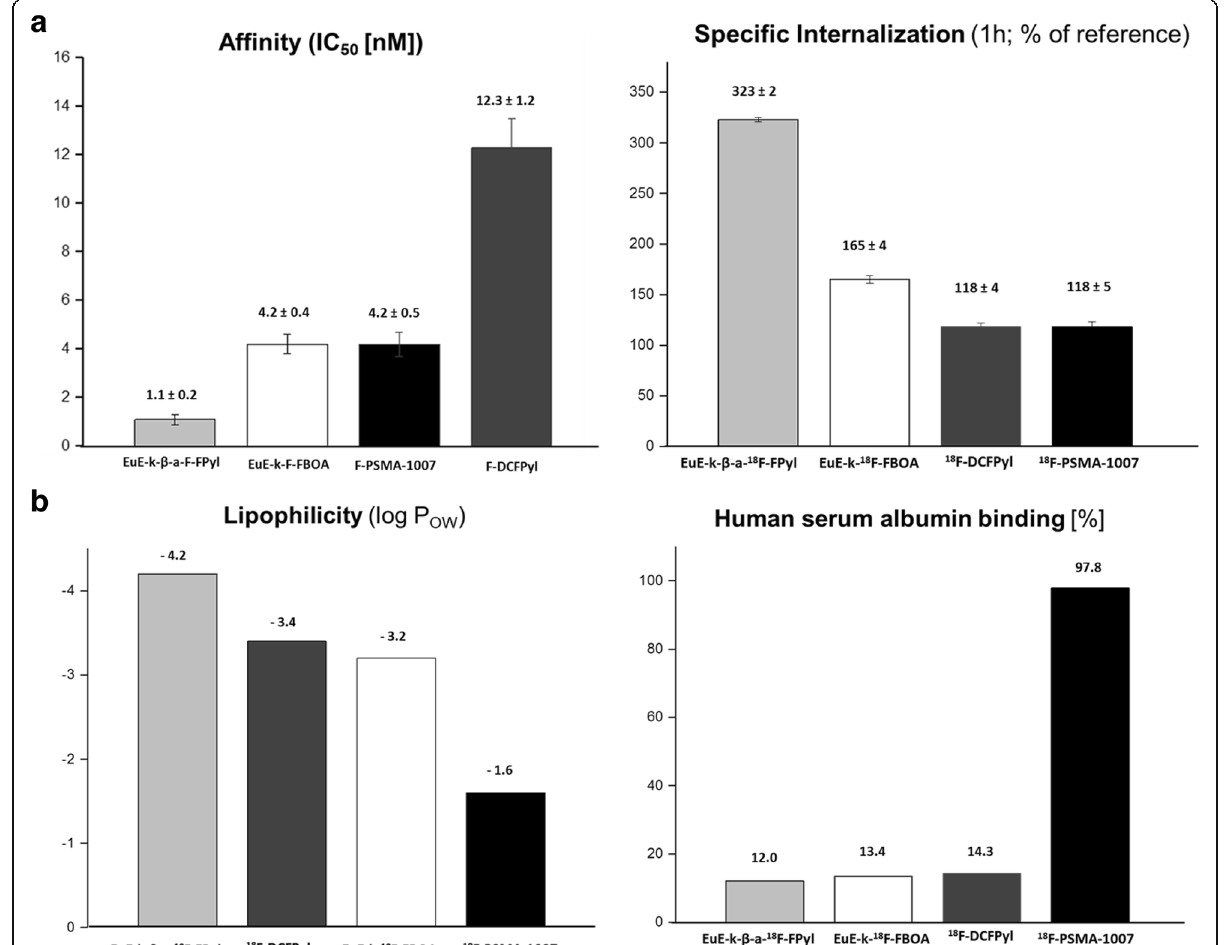
Fig. 2 a PSMA affinities of the cold EuE-based inhibitors, F-DCFPyl and F-PSMA-1007. Internalization of the 18 F-labeled EuE-based PSMA inhibitors, EuE-k- 18 F-FBOA and EuE-k- β -a- 18 F-FPyl in comparison to 18 F-DCFPyl and 18 F-PSMA-1007. b Lipophilicity and HSA-binding of EuE-k- 18 F-FBOA, EuE- k- β -a- 18 F-FPyl, 18 F-DCFPyl, and 18 F-PSMA-1007. *Specific internalization of the reference compound (( 125 I)I-BA)KuE assayed in a parallel experiment and used for data